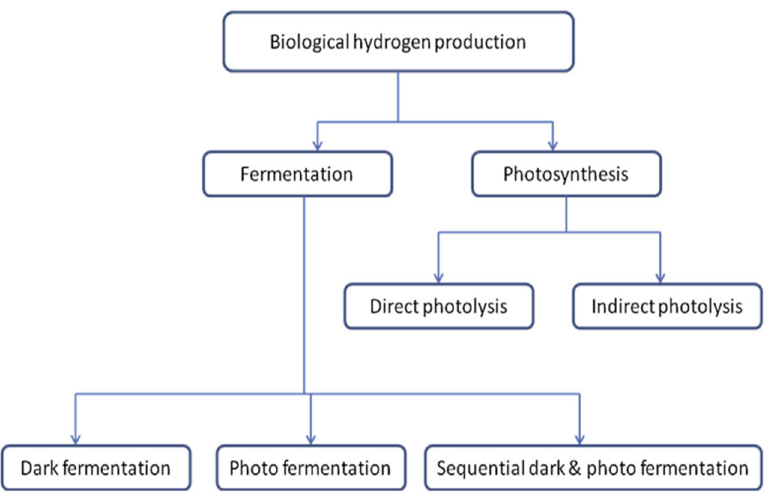
Figure 1. Methods of producing